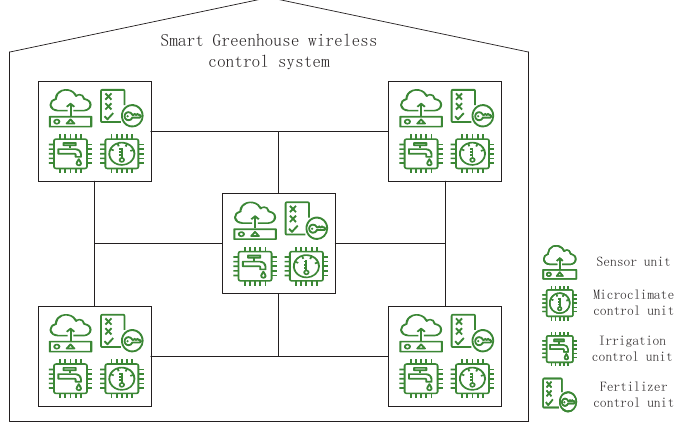
Figure 2. The structure of smart